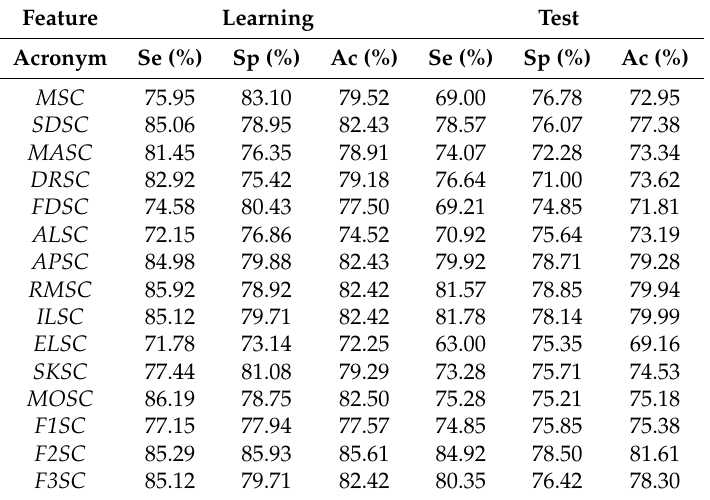
Table 3. Sensitivity (Se), specificity (Sp) and accuracy (Ac) for all the parameters under study and for training and test